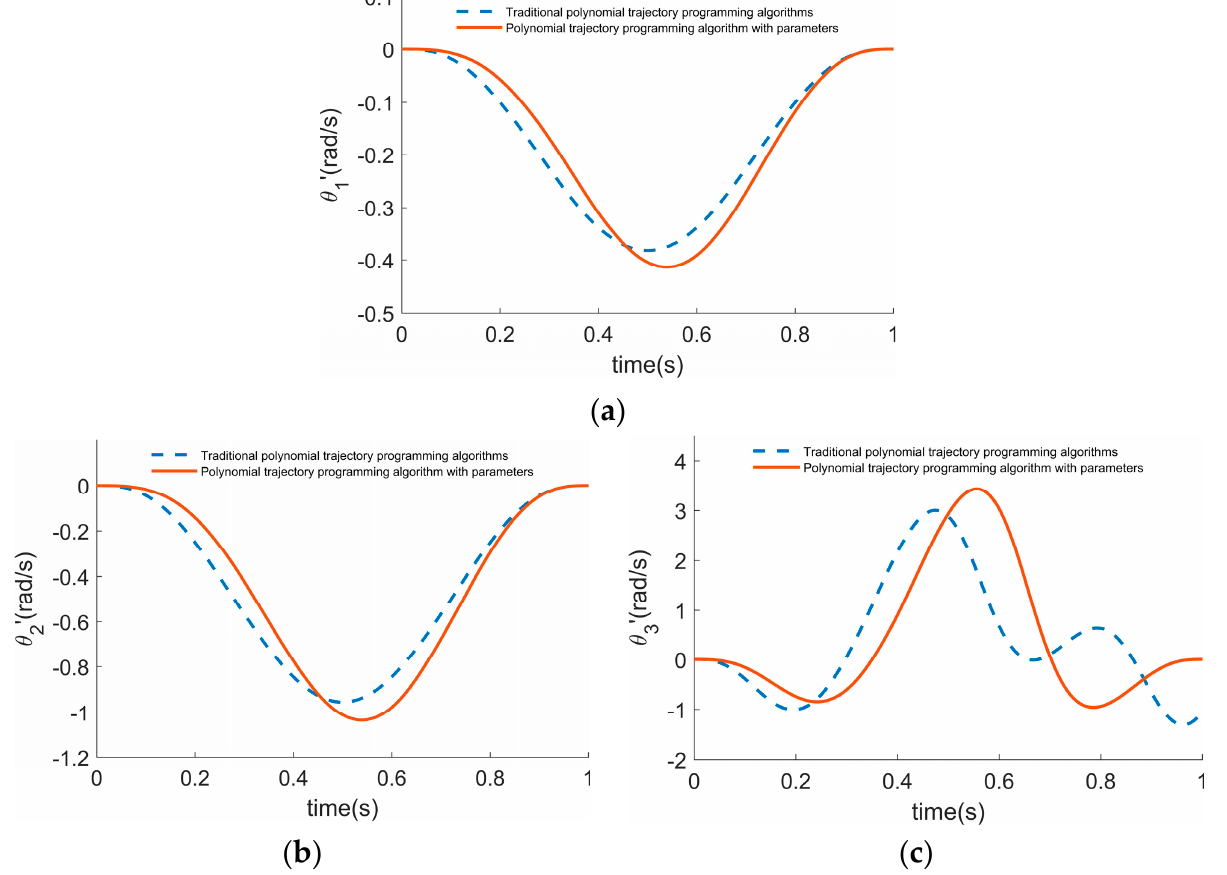
Figure 10. Angular velocity of the solution under the two planning algorithms. ( a ) Comparison of θ 1 − angular velocity; ( b ) Comparison of θ 2 − angle velocity; ( c ) Comparison of θ 3 − angle velocity